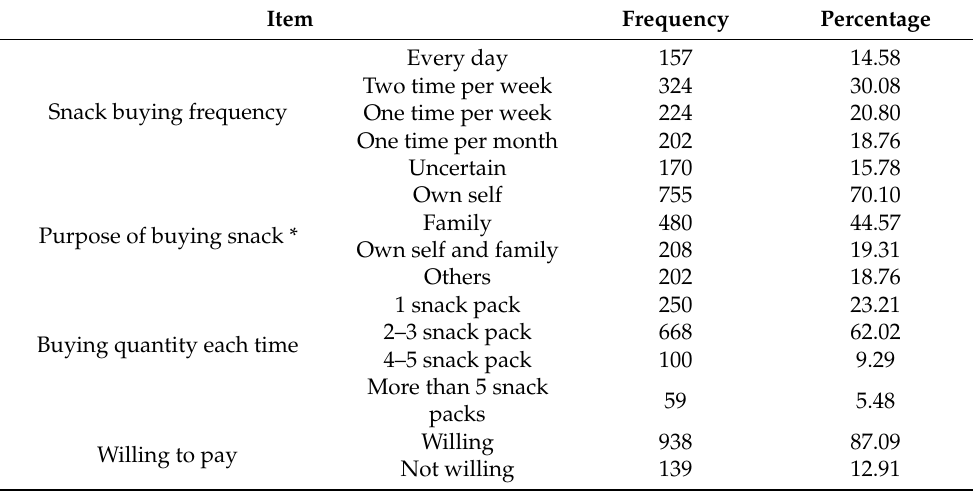
Table 3. Buying behavior and marginal willingness to pay for acrylamide-free cassava chips. Item Frequency Percentage